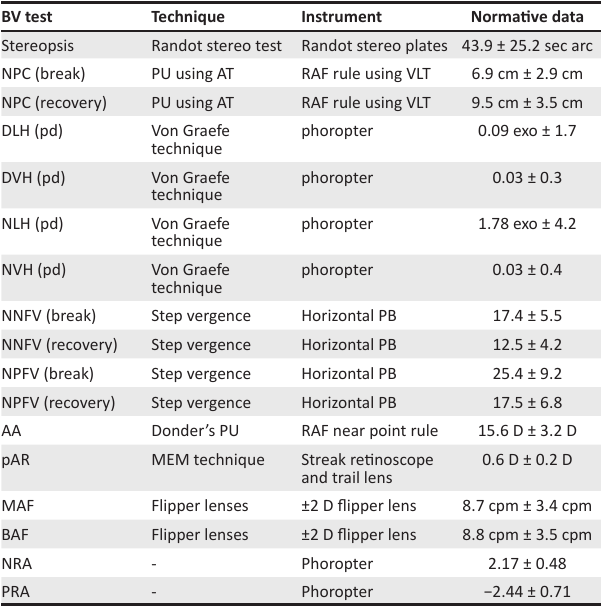
TABLE 7: Binocular vision parameters and normative data from Wajuihian. 8 BV test Technique Instrument Normative